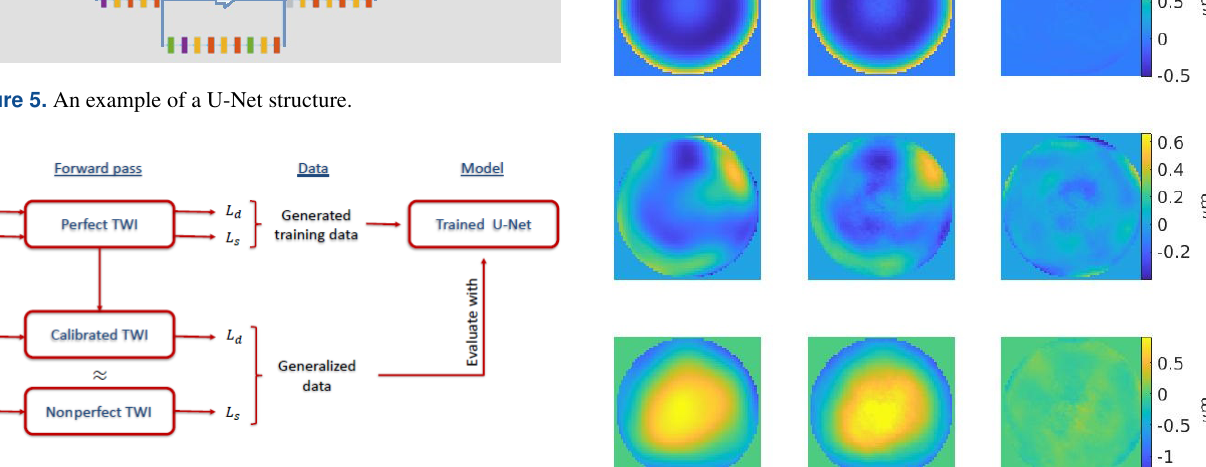
Figure 6. Workflow of the developed hybrid method.